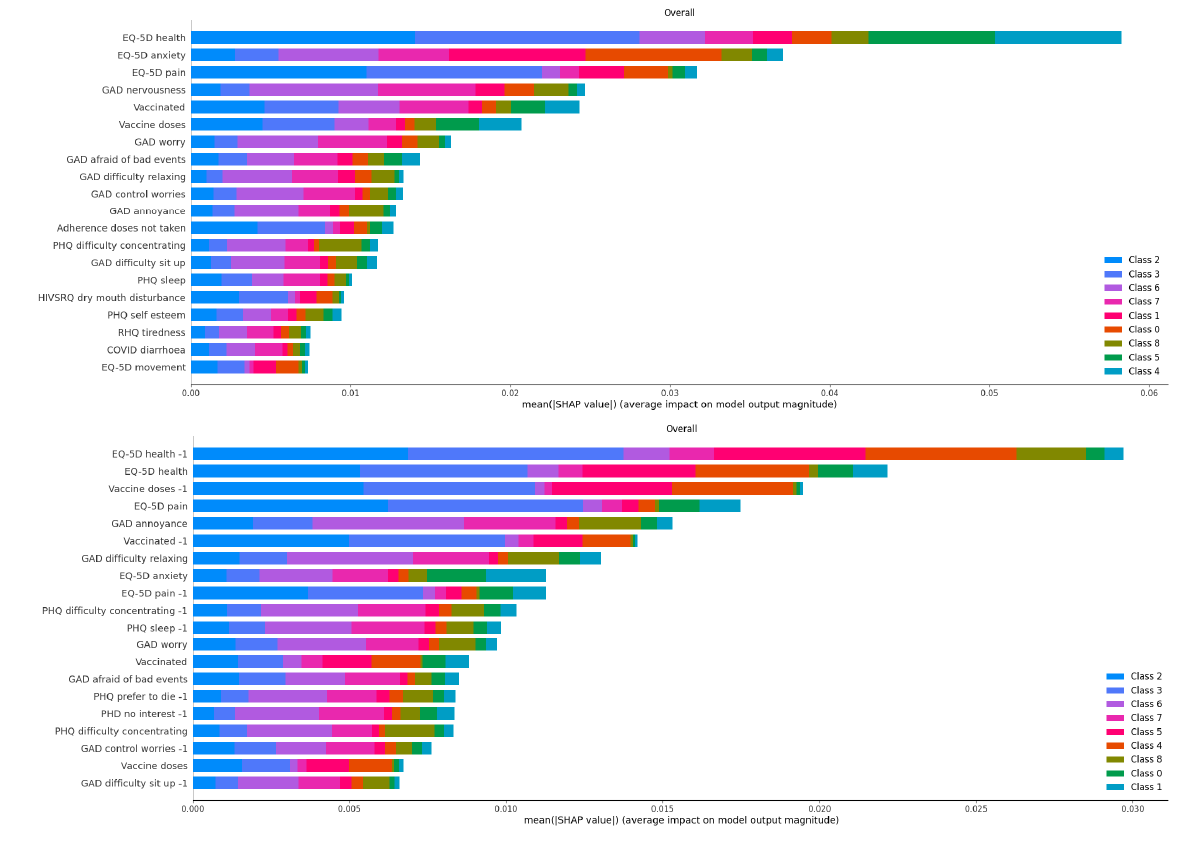
Figure 6. Comparison of the most important factors of the prediction (across all outcomes) for one month history ( top ) and two months history ( bottom ).